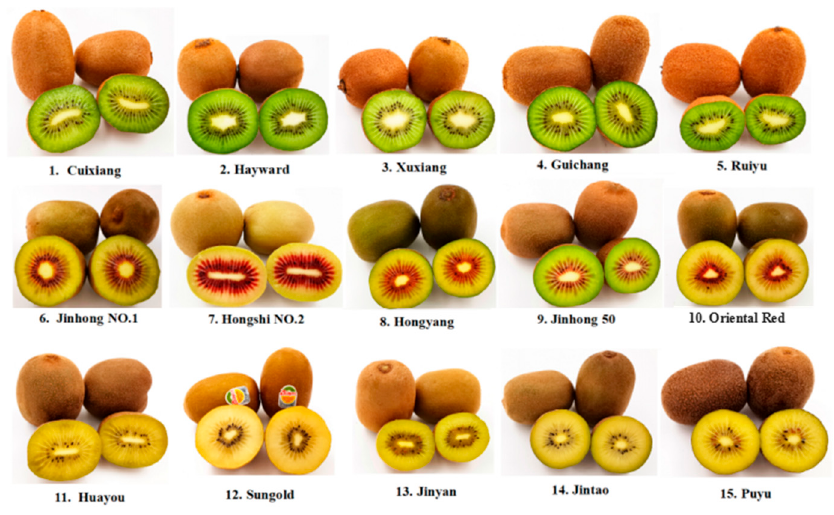
Figure 1. Sample photos of 15 kiwifruit ( Actinidia ) cultivars. Table 1. Cultivars, species, flesh color and regions of kiwifruits.